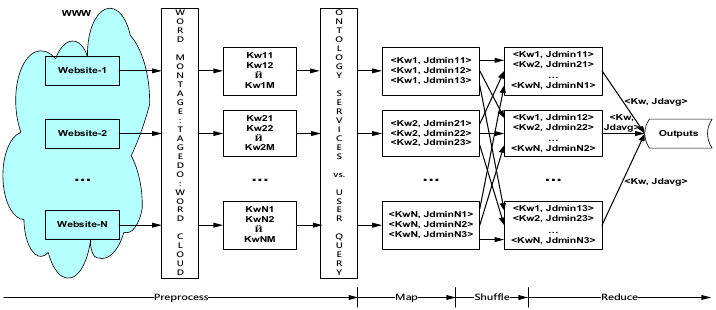
Figure 4. Proposed parallel reduction mechanism.